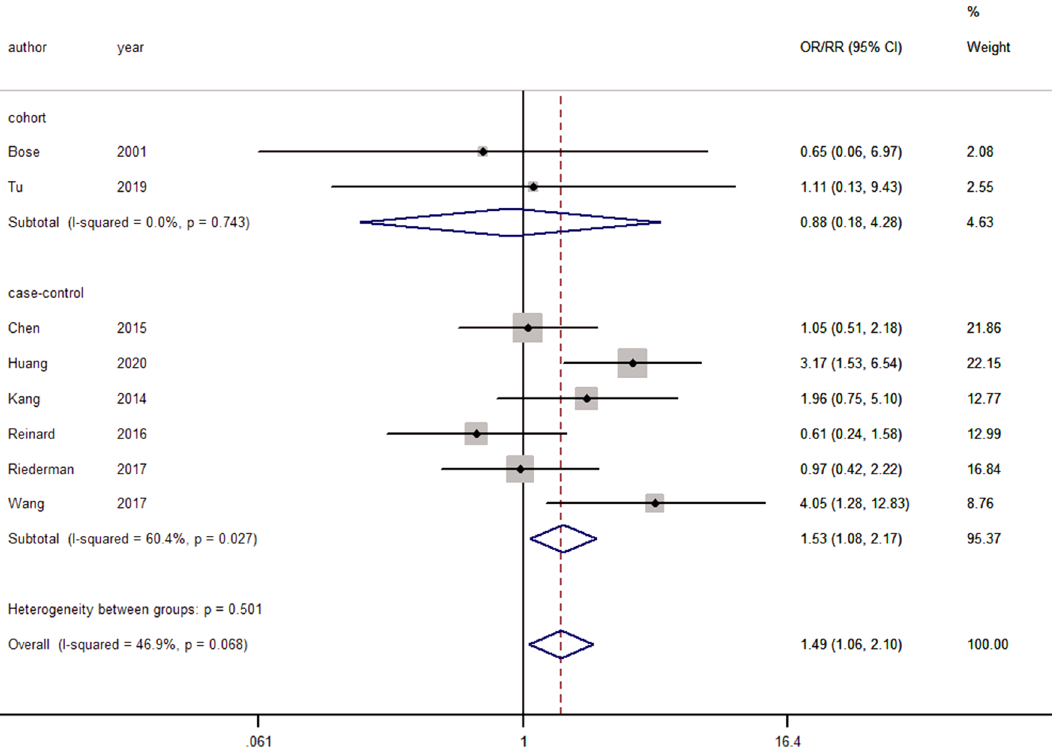
Figure 6. Forest plot showing the effect of smoking on dysphagia. OR, odd rate; RR, risk rate; CI, confidence interval.